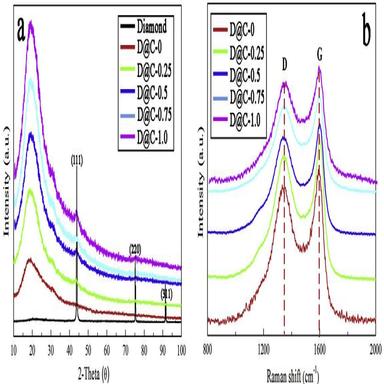
(a) XRD patterns of pristine diamond and D@C-x composite particles, (b) Raman spectra of D@C-x composite particles.